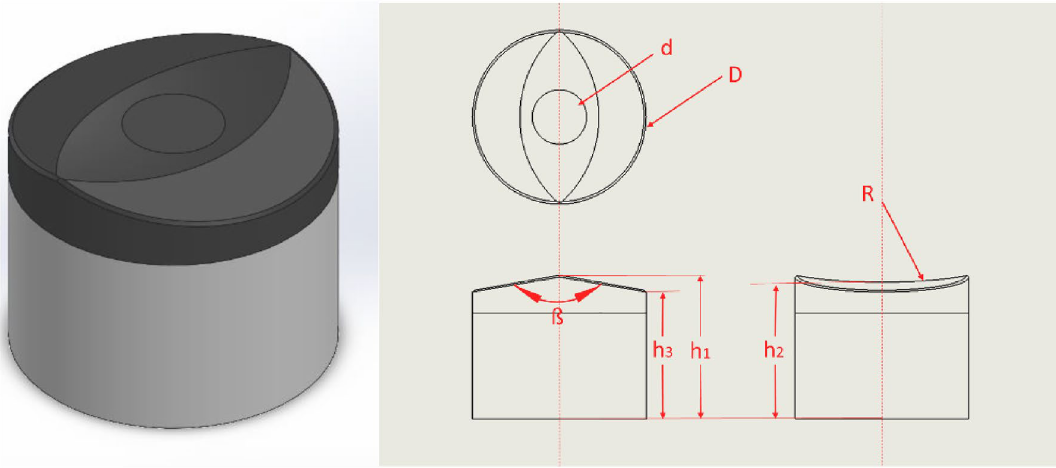
Fig. 1 3D schematic diagram and structural parameters of the 3D concave-shaped